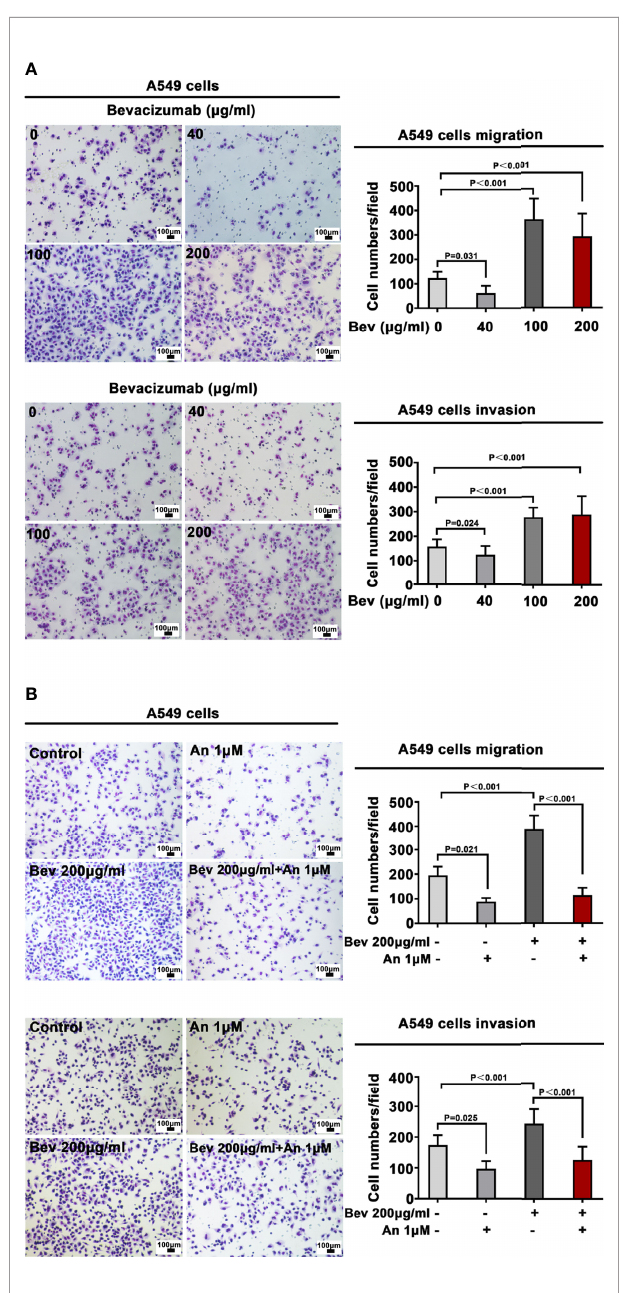
FIGURE 1 | Bevacizumab promotes A549 cell migration and invasion. (A) Migration and invasion of A549 cells under different concentrations of bevacizumab. (B) Migration and invasion of A549 cells treated with 200 m g/ mL bevacizumab, 1 m M anlotinib, or both. Representative images are shown. Magni fi cation ×200. n=3. Bev: